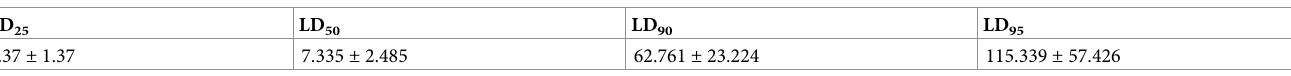
Table 1. Lethal dose estimates of Steinernema yirgalemense per Lobesia vanillana larvae, calculated using probit analysis. LD 25 LD